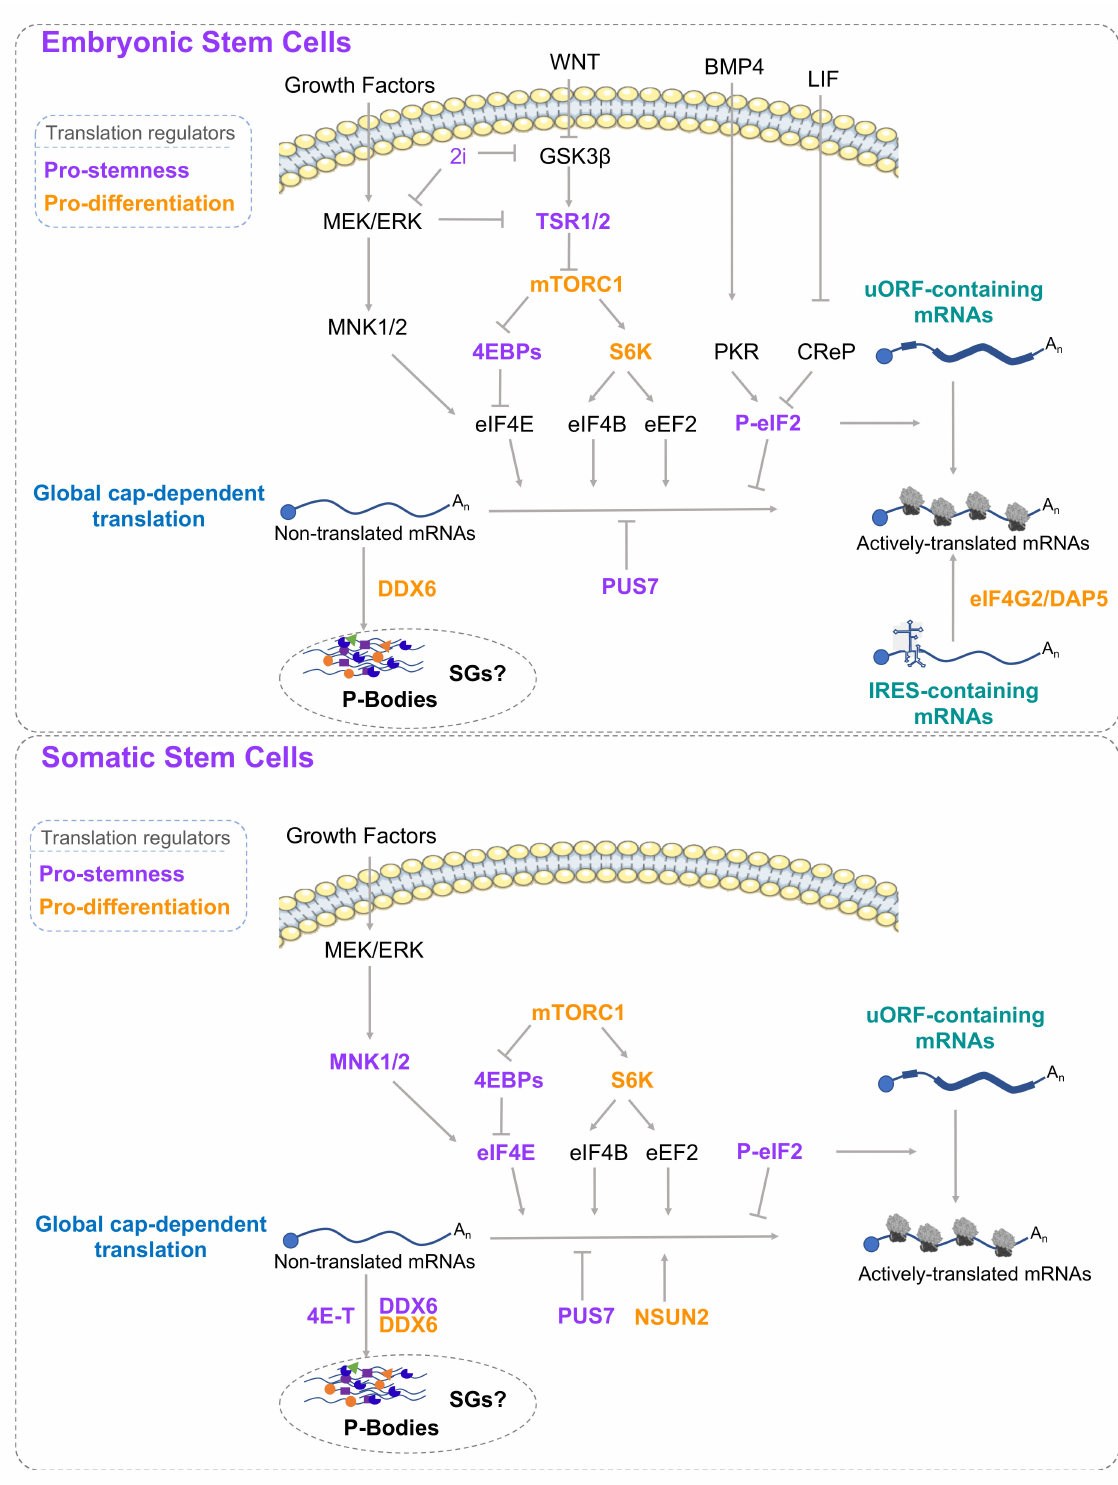
Figure 1. Translational control in stem cells. Upper panel: main signaling pathways that may regulate translational e ffi ciency in embryonic stem cells. Translation regulators that promote stemness or in contrast stimulate di ff erentiation are depicted in purple or orange, respectively. Lower panel: Similar to the upper panel in somatic stem cells. Translation regulators that promote stemness or induce di ff erentiation are depicted in purple or orange, respectively. Images of cell membranes were kindly provided by the SMART Servier medical art database